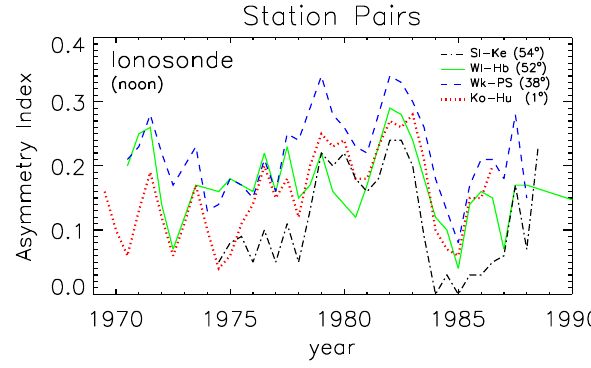
Fig. 3. Variation of the annual asymmetry in peak electron density at noon for four station pairs over two solar cycles, computed from ionosonde data. Table 2. Asymmetry index in ionosonde N mF2 for Singapore- Talara (near geographic equator) and Kodaikanal-Huancayo (near geomagnetic